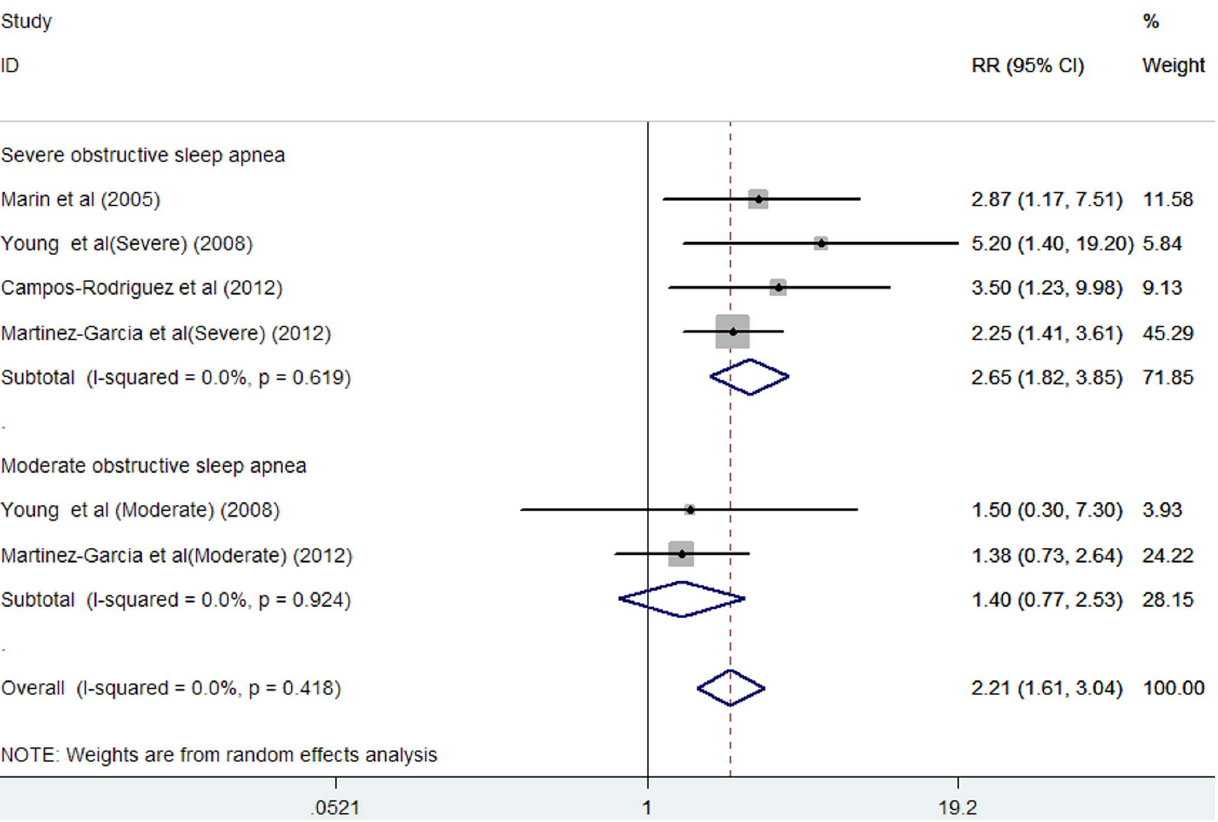
Figure 3. HR and 95% CI from the included studies of moderate and severe OSA with cardiovascular mortality comparing OSA to the